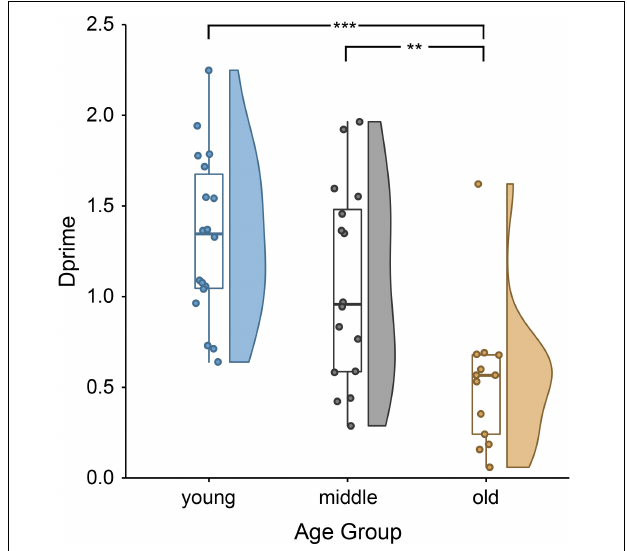
FIGURE 1 | Lower sentence comprehension accuracy, indirectly indicating lower encoding success, for older than younger and middle-aged adults: single subject means (scatter points), group medians (line within boxes), as well as probability density of d-prime values of younger, middle-aged and older adults (for more information on raincloud plots, see Allen et al., 2019). ∗∗∗ p < 0.001 and ∗∗ p <